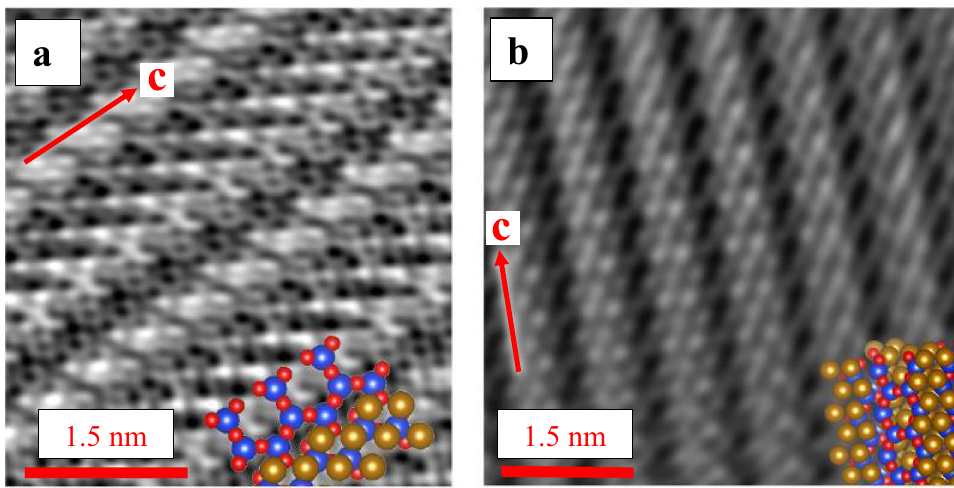
Figure 3. Two different orientations of the crystalline core region of amosite with superimposed crystal structure, where the blue, red and orange atoms represent Si, O, and Fe, respectively. AcSTEM images showing